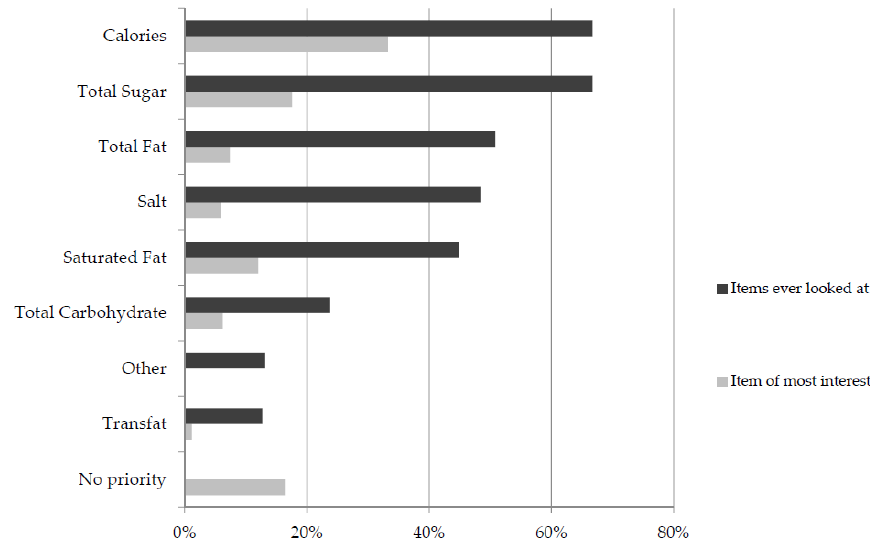
Figure 1. Nutrition panel items looked at by consumers and item of most interest, n = 433.